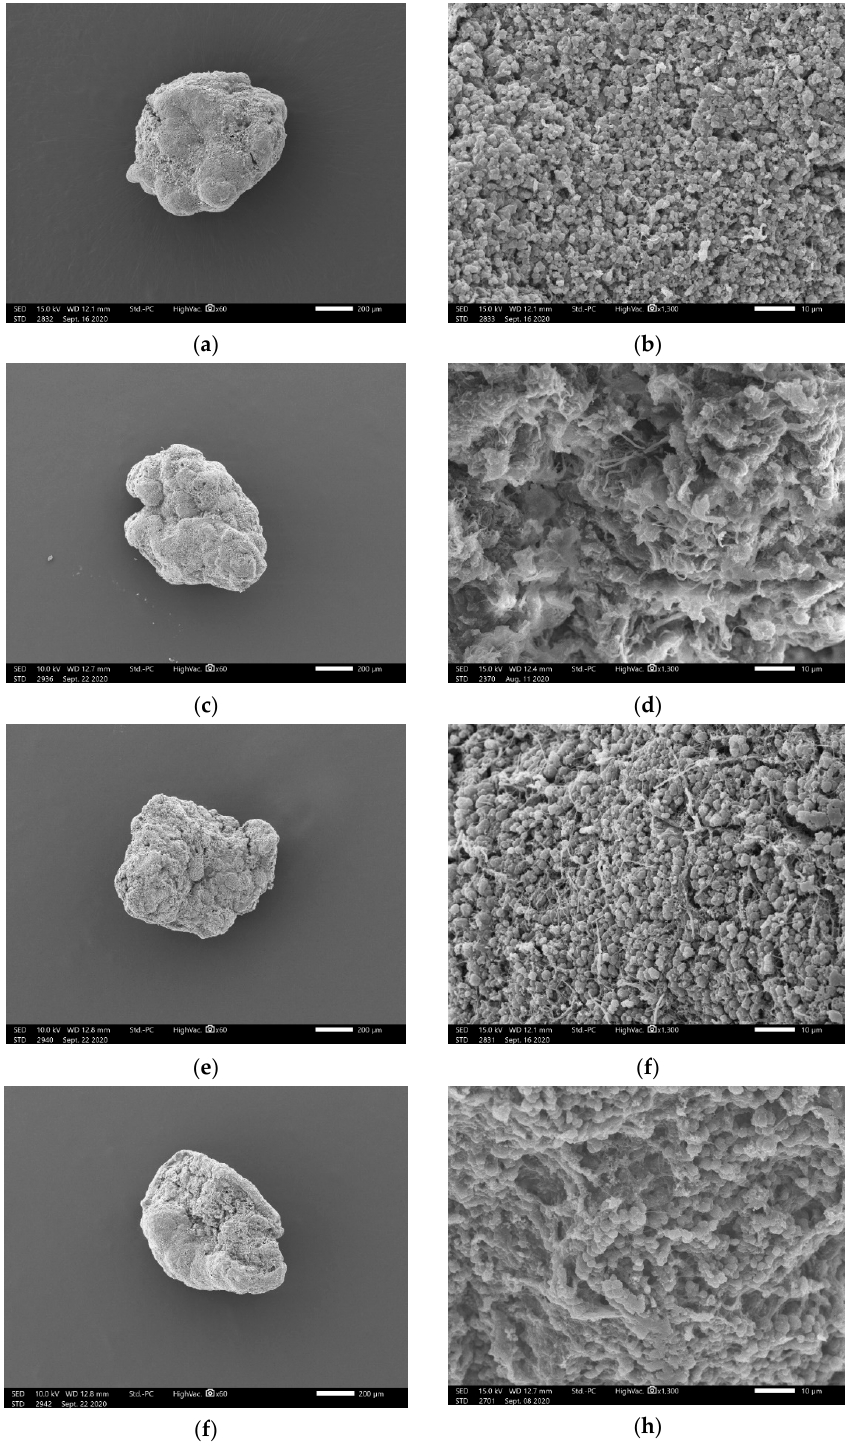
Figure 3. SEM images of particles and surface for anammox granules according to cation additions at 5 g NaCl/L: ( a ) The particles of an anammox granule without salt; ( b ) The surface of an anammox granule without salt; ( c ) The particles of an anammox granule at 5 g NaCl; ( d ) The surface of an anammox granule at 5 g NaCl/L; ( e ) The particles of an anammox granule with 200 mg/L Ca 2+ at 5 g NaCl/L; ( f ) The surface of an anammox granule with 200 mg/L Ca 2+ at 5 g NaCl; ( g ) The particles of an anammox granule with 70 mg/L Mg 2+ at 5 g NaCl/L; ( h ) The surface of an anammox granule with 70 mg/L Mg 2+ at 5 g